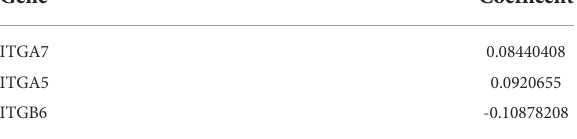
TABLE 2 The regression coef fi cients of three gene characterastics calculated by LASSO regression